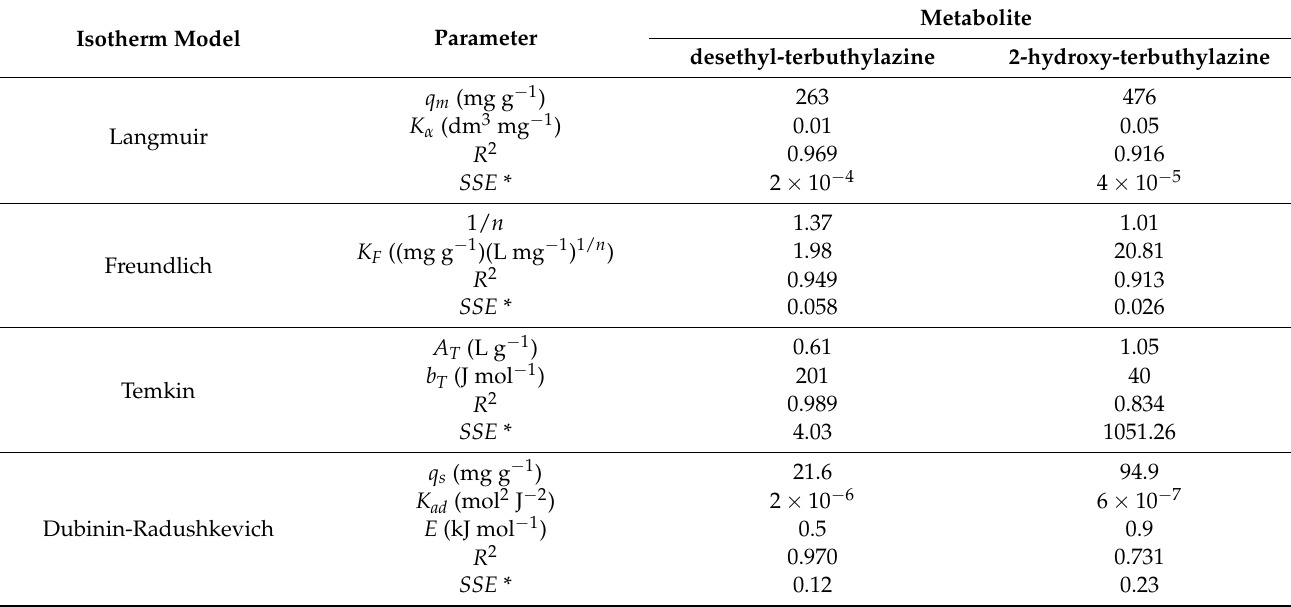
Table 4. Parameters of Langmuir, Freundlich, Temkin and Dubinin–Radushkevich isotherm models. Isotherm Model Parameter